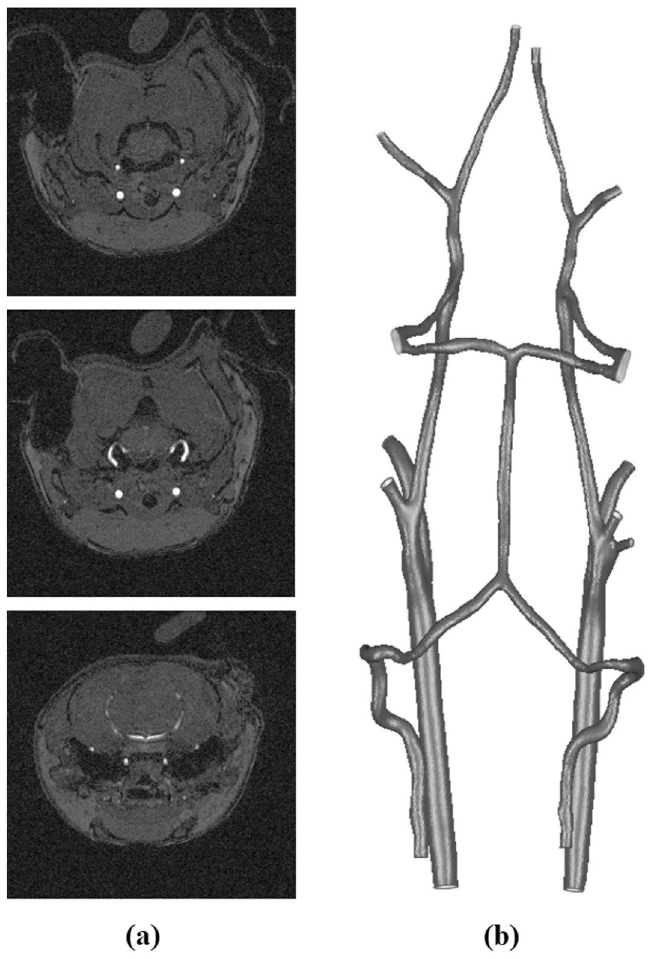
Figure 1. Reconstruction stages of the vascular network geometry for one of the animals: ( a ) MRI data, ( b ) vector